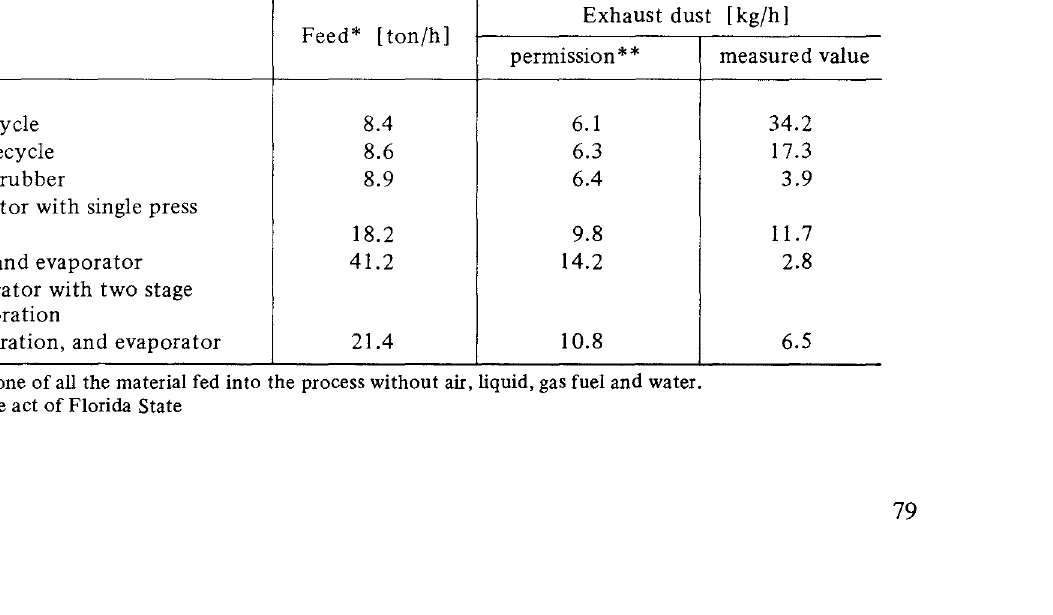
Table 4 Dust concentration in stack gas from citrus p!up and peel dehydrators 2) Feed*